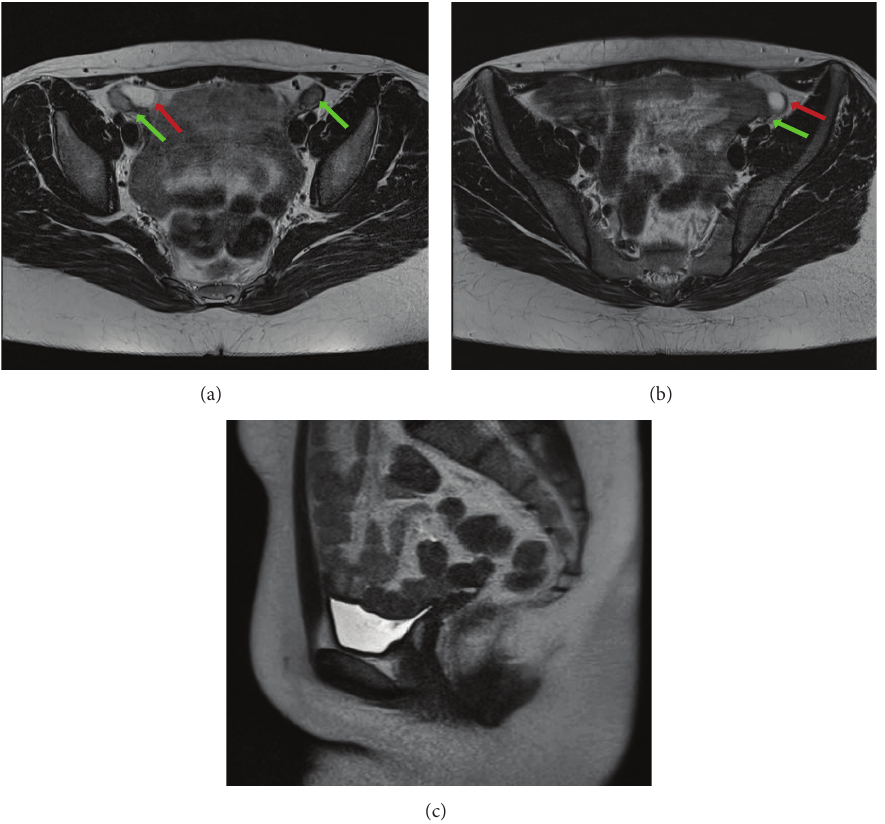
Figure 3: 22-year-old girl/female affected by CAIS. Axial and coronal T2-weighted images ((a) and (b)) revealing the testes (green arrows) with adjoining cysts on both sides (red arrows). Sagittal image (c) showing absence of the M¨ullerian structures and the presence of the lower vagina (yellow arrowheads). (3T Magnetic Resonance Imaging. Axial 4mm fast T2-weighted image, TR/TE 5030/119; sagittal 5mm HASTE- sequence, TR/TE